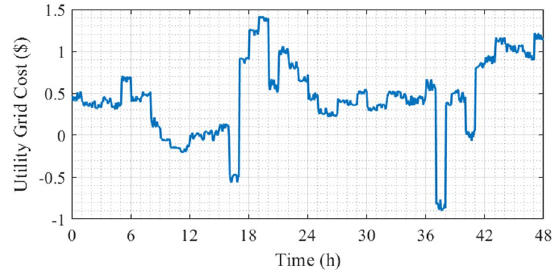
Fig. 9 Utility grid regulation cost during dispatch horizon